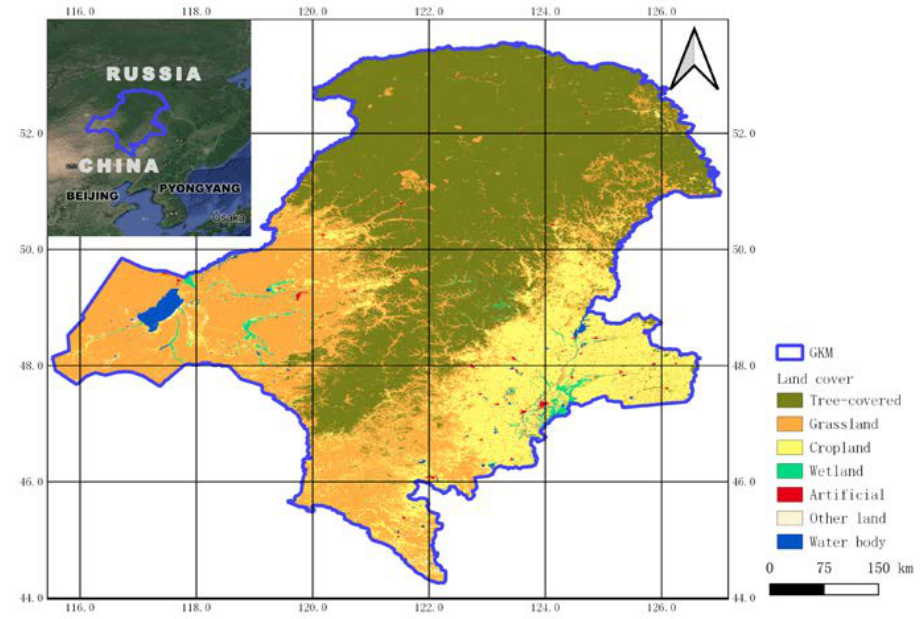
Figure 1. Land use and land cover in Great Khingan Mountain (GKM), China in 2000.